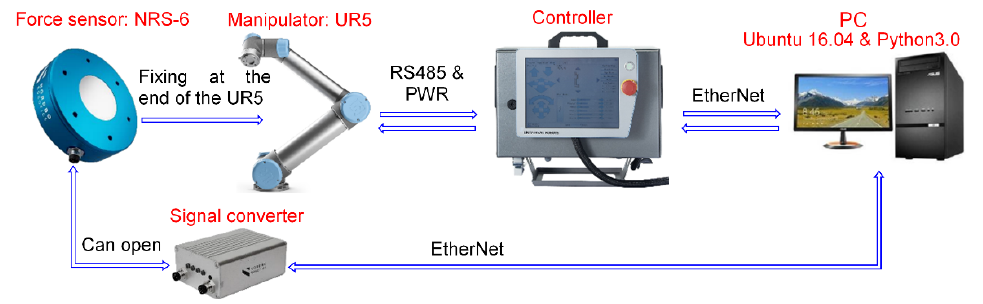
10 of 17 Figure 6. Simulations on complex surface. Force tracking using ( a ) the HFPC and ( b ) proposed CFPC methods. ( c ) Position tracking. ( d ) Weighted parameter wi s . 3.2. Experiments The proposed CFPC method was also verified through physical experiments. The experimental platform mainly comprises a computer (Intel Core i7: Intel Corporation, Ub-